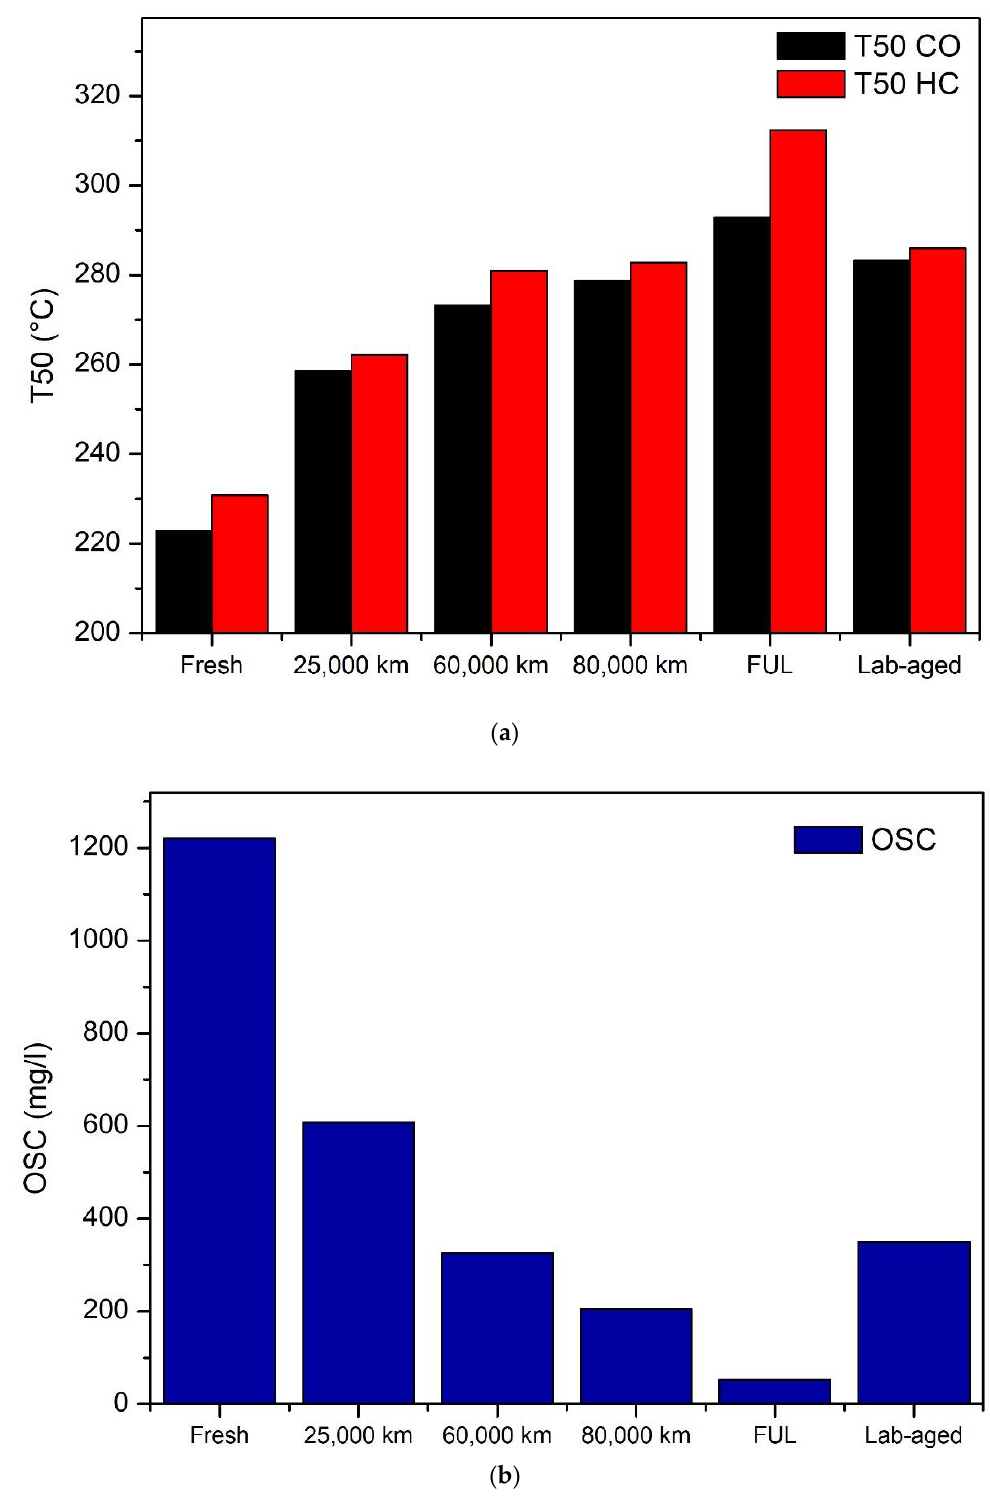
Figure 7. Light-off temperature ( a ) and Oxygen storage capacity ( b ) measured on catalysts samples .